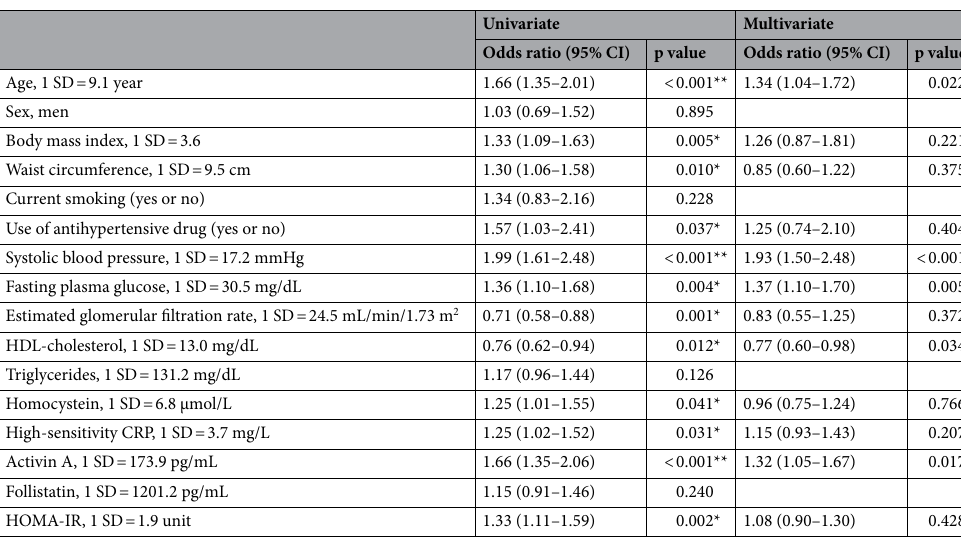
Table 3. Logistic regression analysis of risk factors associated with microalbuminuria and overt albuminuria. *p < 0.05, ** p < 0.001. CRP C-reactive protein, HDL high-density lipoprotein, HOMA-IR homeostasis model assessment-estimated insulin resistance.